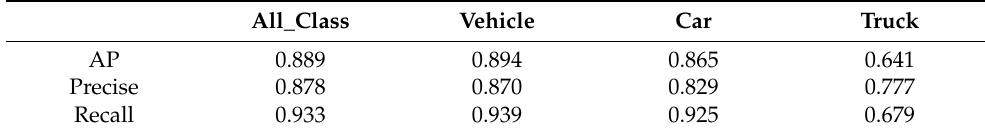
Figure 11. The result of the vehicle detector. Table 1. The performance of the detector at different